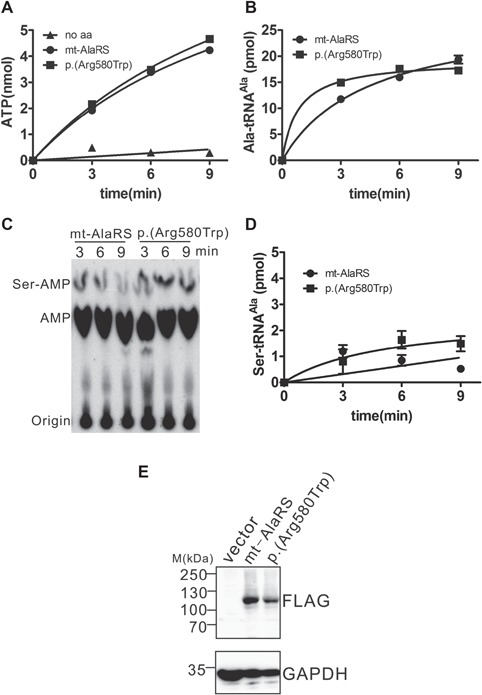

In vitro studies of the human mt-AlaRS p.Arg580Trp mutant. (A) ATP-PPi exchange determination of human mt-AlaRS (•) and the p.Arg580Trp mutant (▪). A reaction at the absence of Ala was included for a control (▴). (B) Aminoacylation activity of human mt-AlaRS (•) and the p.Arg580Trp mutant (▪). (C) A representative TLC showing the mischarging of mt-tRNAAla by human mt-AlaRS and the p.Arg580Trp mutant. Nuclease S1-generated Ser-[32P]AMP (reflecting Ser-[32P]tRNAAla) and [32P]AMP (reflecting free [32P]tRNAAla) were separated by TLC. (D) Graph of the mischarging activity of human mt-AlaRS (•) and the p.Arg580Trp mutant (▪). In all graphs, the data represent the mean values with error bars indicating standard deviation (SD). (E) Steady-state protein level of overexpressed human mt-AlaRS and the p.Arg580Trp mutant in HEK293T cells. Genes encoding C-terminal FLAG-tagged human mt-AlaRS and p.Arg580Trp mutant were overexpressed in HEK293T cells and the proteins were detected by FLAG antibodies. GAPDH was detected as a loading control.